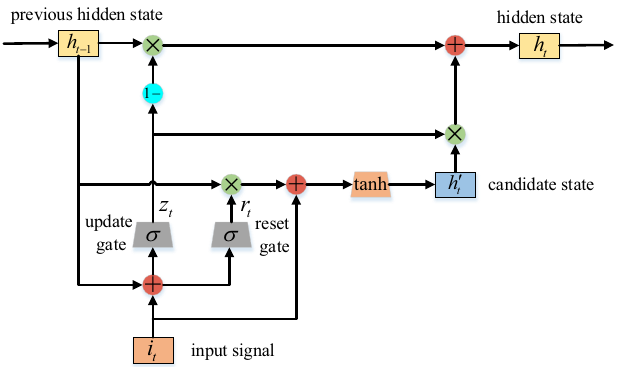
Figure 2. The specific structure of GRU neural network.